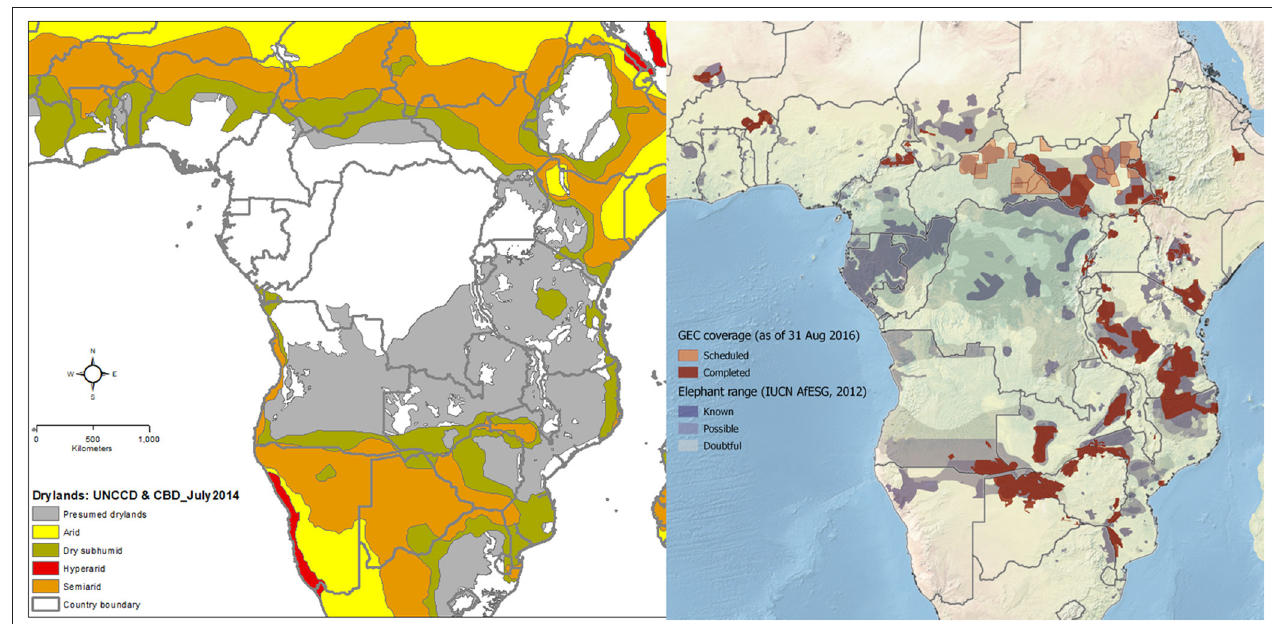
FIGURE 1 | African drylands and present-day elephant range; the drylands map adopted from UNEP-WCMC (2007), and the known elephant range map reproduced from Chase et al. (2016) and Thouless et al. (2016).